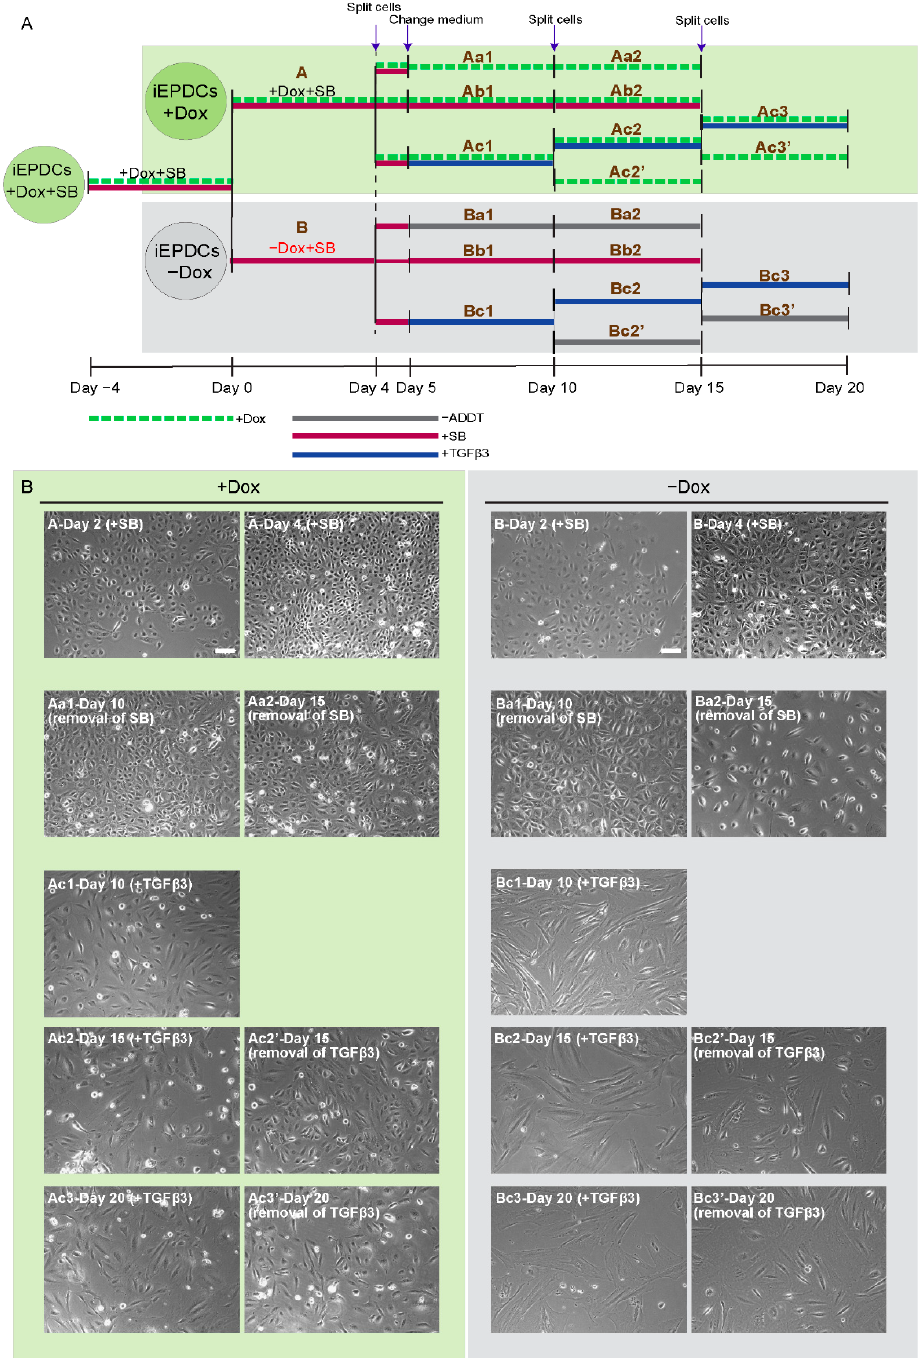
Figure 4. Proliferating iEPDCs show a reduced propensity to undergo EMT upon TGF β 3 stimulation. ( A ). Diagram of the experimental protocol used to examine EMT of actively proliferating (+Dox) and cell cycle-arrested ( − Dox) iEPDCs following exposure to TGF β 3 (1 ng/mL) or various control conditions. ( B ). Representative phase contrast images of iEPDCs subjected to the treatment regimens shown in ( A ). The images on the left panel display the morphology of actively proliferating iEPDCs under each condition, the images in the right panel show the morphology of cell cycle-arrested iEPDCs under each condition. While TGF β 3 treatment readily induces EMT in non-dividing iEPDCs, dividing cells only displayed signs of EMT after prolonged exposure to TGF β 3. Scale bar = 100 µ m. − ADDT = no